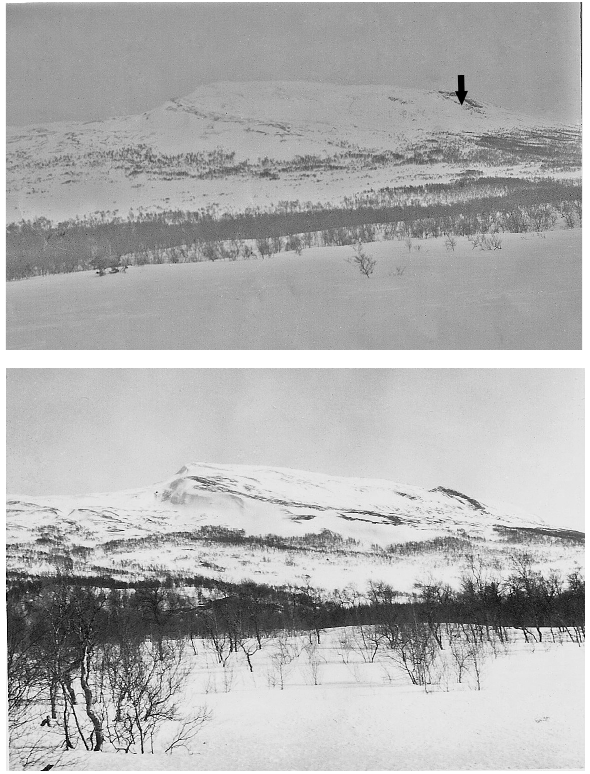
Figure 14: Upper. Mountain side with a fairly sharp “forest line”, coinciding with the treeline. Photo by Harry Smith. 14 April 1914. Lower. Approximately the same view 18 April 2007. The upper forest band has become denser and the “forest line” may be somewhat higher. Although not visible here, the treeline (arrow) has advanced substantially and is currently 125 m higher than in 1915. Mt.